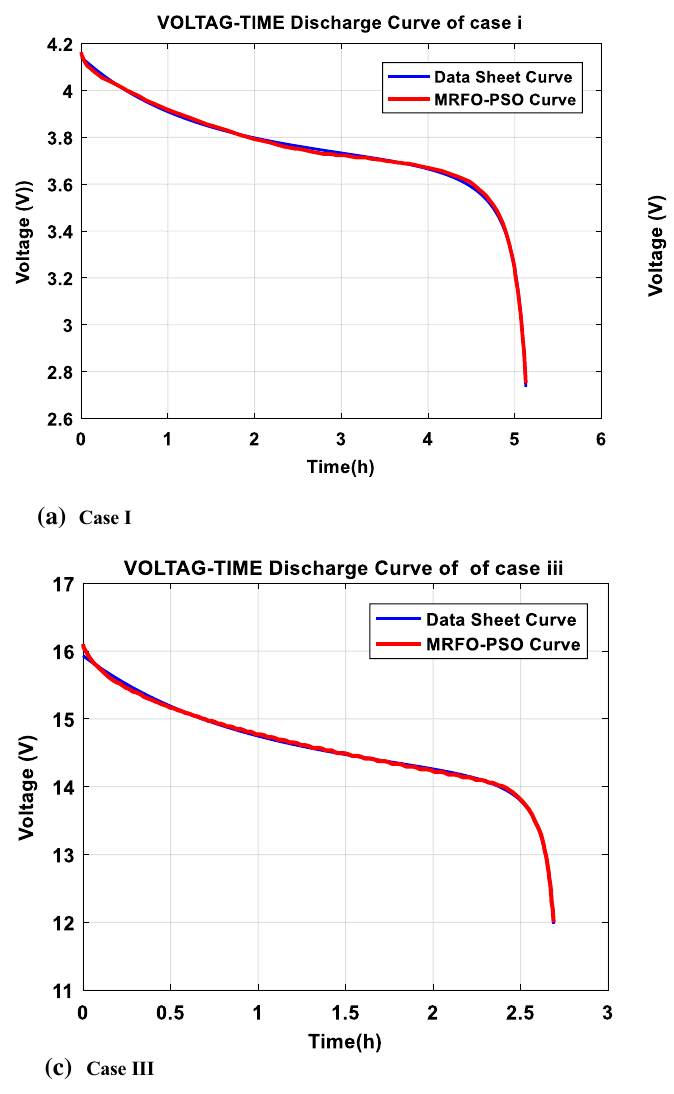
Fig. 8 Discharge curve of extracted parameters by proposed MRFO-PSO for the studied cases